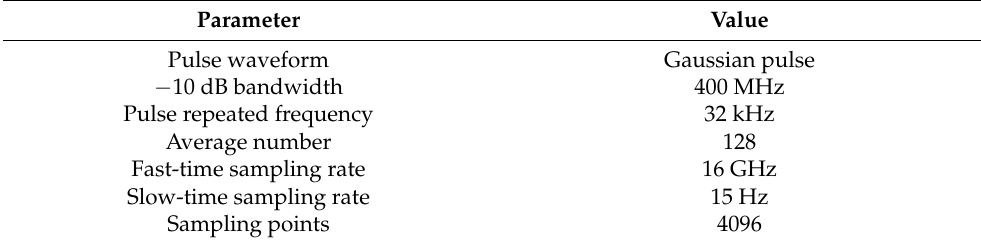
Table 2. Parameters of the developed UWB impulse radar.